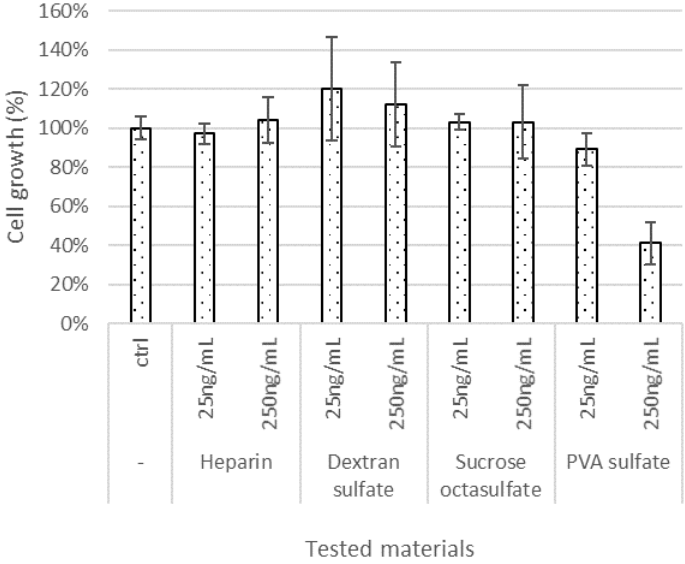
Figure 3. Effects of sulfated compounds on iPSC proliferation. The percentage cell growth observed for each test material at different concentrations is shown. Microsoft Excel for Microsoft Apps for Enterprise was used for the preparation of the figure.